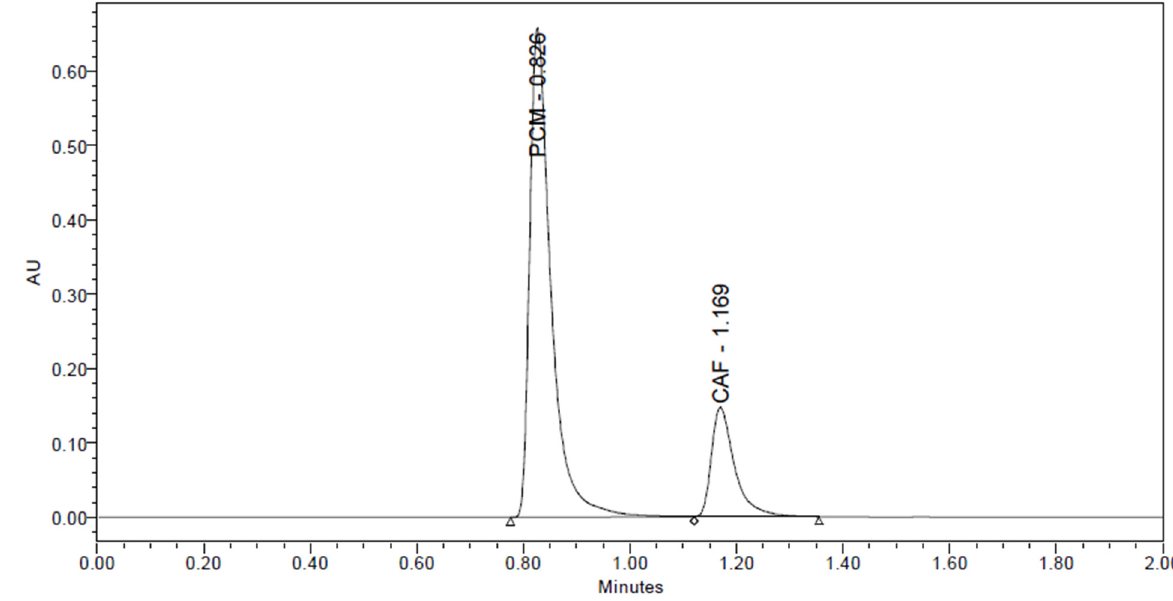
Figure 2. Spectra of PCM and CAF obtained via PDA detector in ( A ) standard, ( B ) Tab-1, ( C ) Tab-2, ( D ) Tab-3, ( E ) Cap-1.